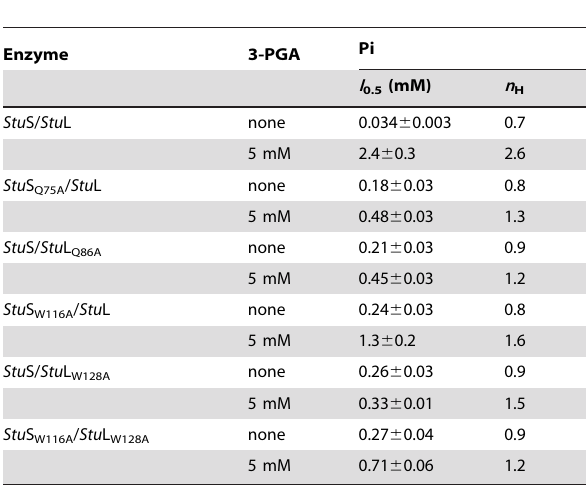
Table 3. Kinetic parameters obtained for Pi with the potato tuber ADP-Glc PPase and its